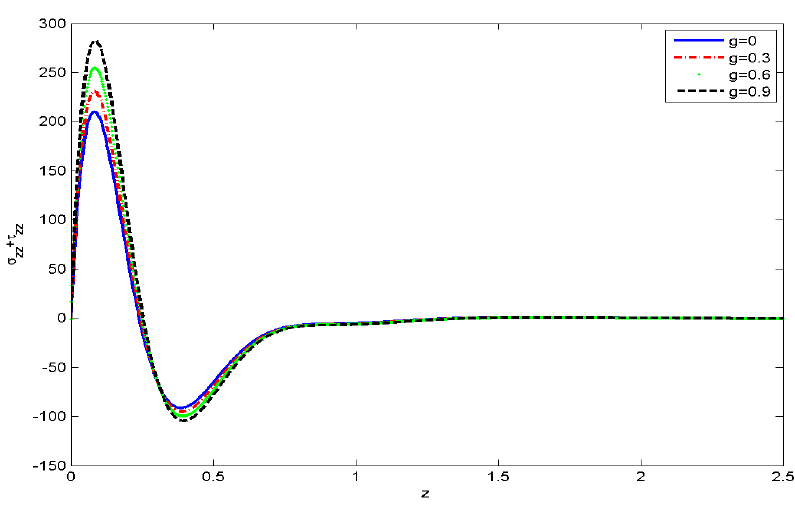
Figure 32. Total stress τ zz + σ zz concerning z with gravity g.